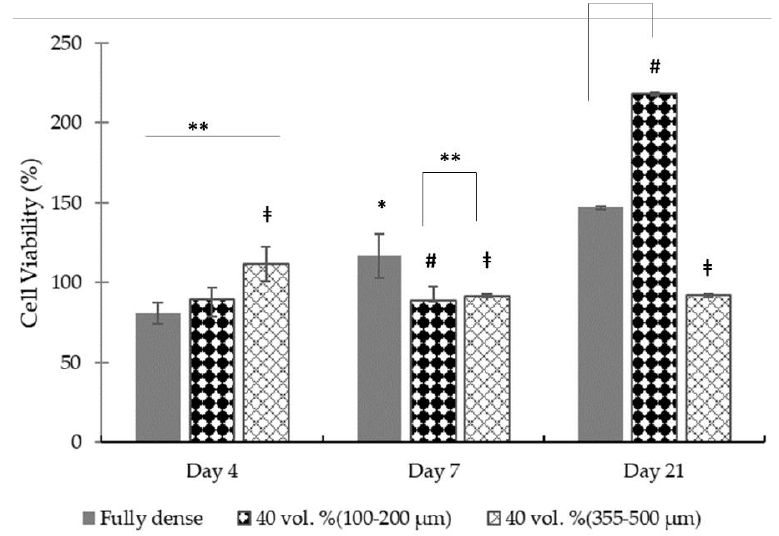
Figure 4. Cell metabolic activity in proliferation stage determined by AlamarBlue assay of MC3T3 cell line at 4, 7 and 21 days. Significance level at p -value < 0.05; (*) fully-dense 4 days vs. 21 and 7 days vs. 21 days. (#) 40 vol.% (100–200 µ m) 4 days vs. 7 days and 21 days; ( ‡ ) 40 vol.% (355–500 µ m) 4 days vs. 7 and 21 days, 7 days vs. 21 days. A p -value of <0.01 (**) indicate statistics differences.